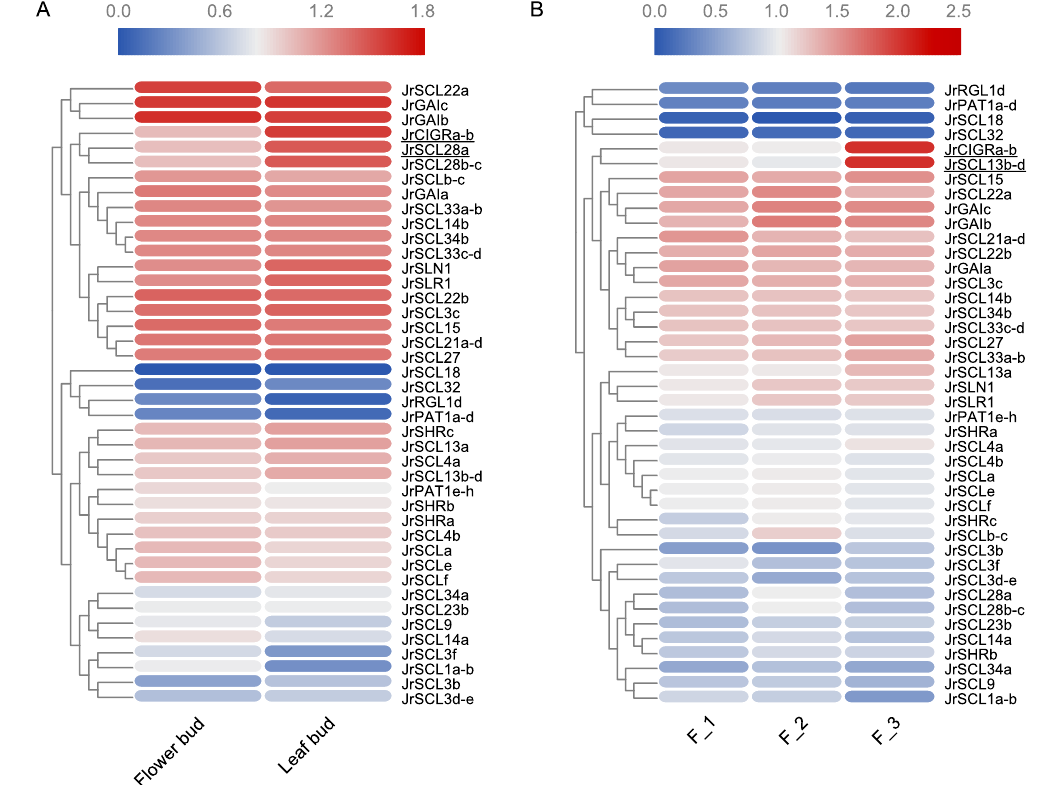
Figure 5. ( A) Heatmap of the JrGRAS genes between flower buds and leaf buds. ( B) Heatmap of JrGRAS genes expressed differently in three development periods of flower buds (F_1, F_2, and